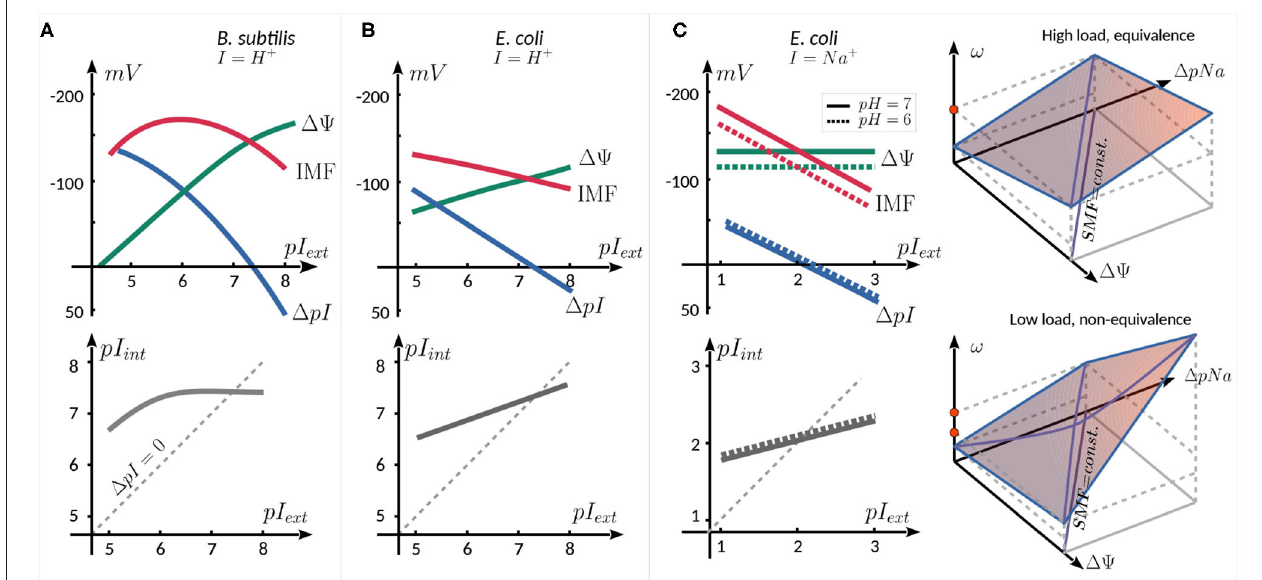
FIGURE 2 | Schematic relation between 19 , 1 pI , IMF (top panels), and pI int (bottom panels) as a function of external ion concentration. The graphs are reproduced from the data published in (A) ( Shioi et al., 1980), for the proton consuming motor of B. subtilis , (B) Minamino et al. (2003), for the proton consuming motor of E. coli , and (C) Lo et al. (2007) for the sodium consuming chimeric motor of E. coli employing chimeric Na + stators. The two rightmost panels in (C) show schematically the equivalence of the SMF components at high load (top), and their nonequivalence (bottom panel, see text).